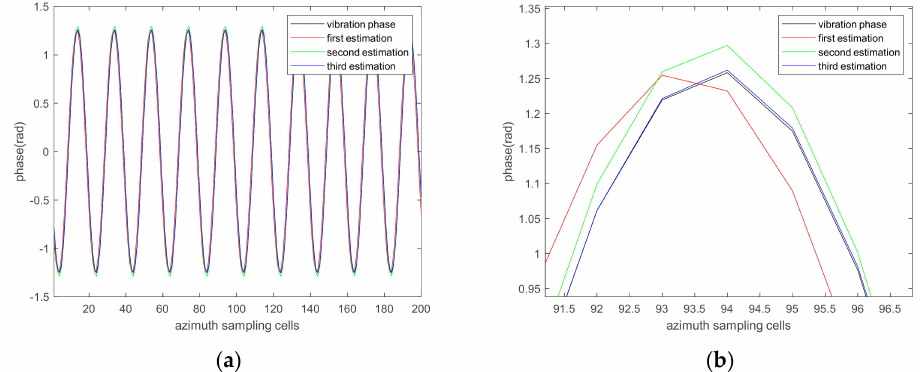
Figure 8. ( a ) Vibration phase and its estimated values under condition 1. ( b ) Partial enlargement of ( a ).